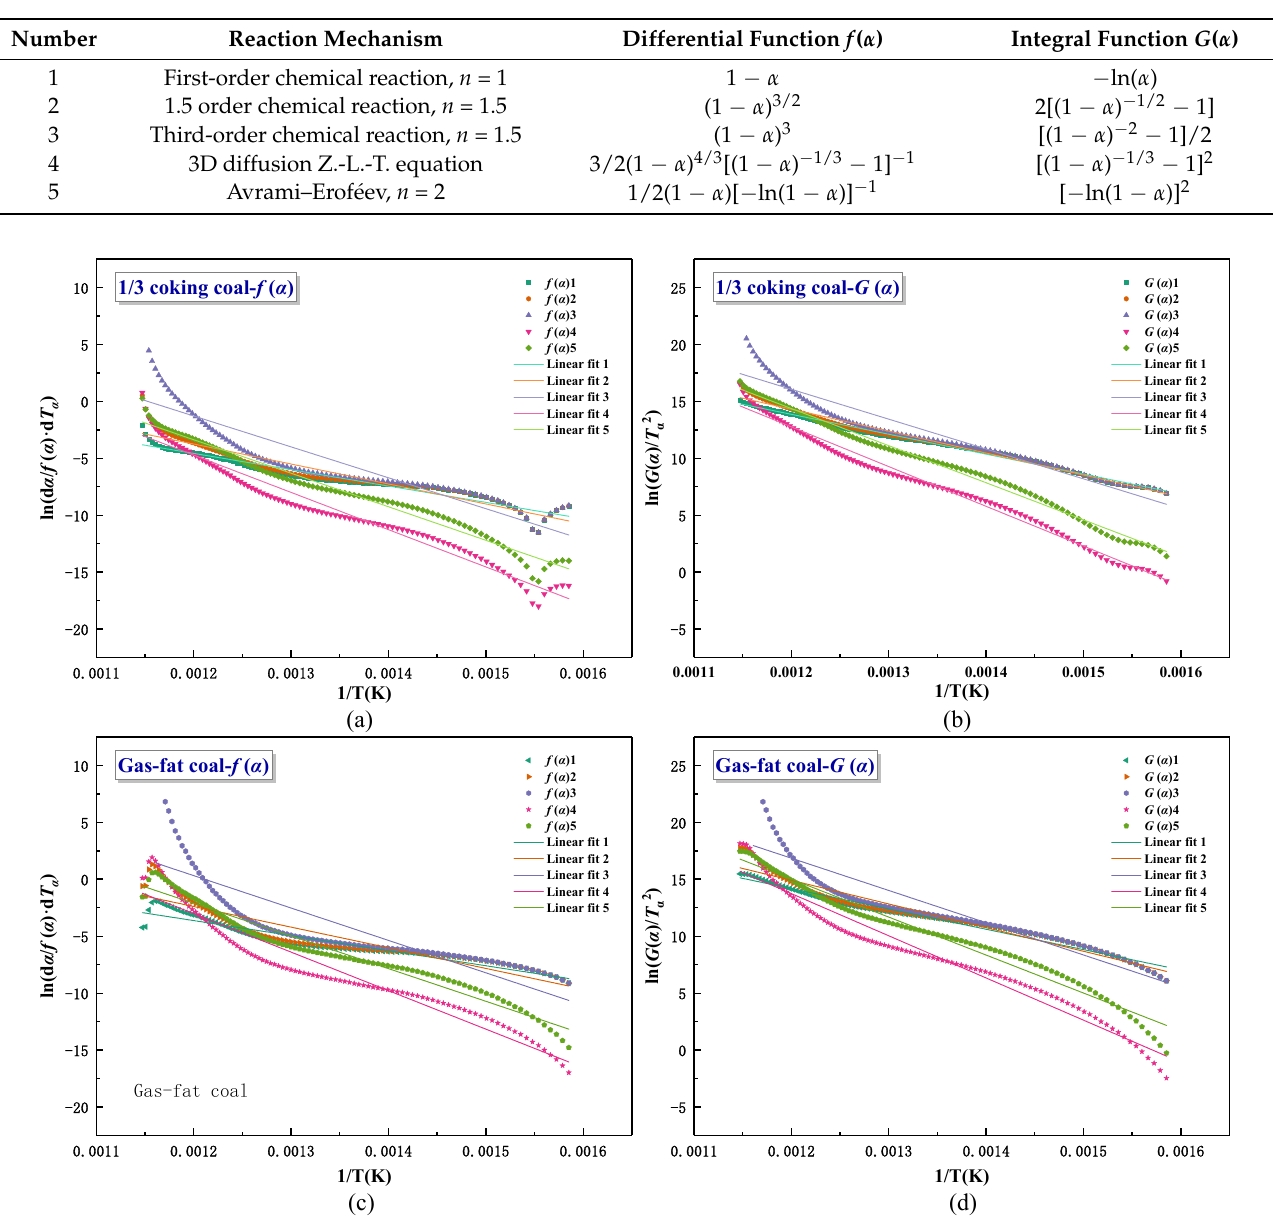
Figure 5. E a values of 1/3 coking coal and gas-fat coal calculation by the Achar differential and Coats- Redfern Integral method with five functions. 3.6. Thermokinetic Multiple Linear Regression Analysis The multiple linear regression method was employed for comparison and verifica- tion to confirm the accuracy of the results of the kinetic calculations [50]. The complex